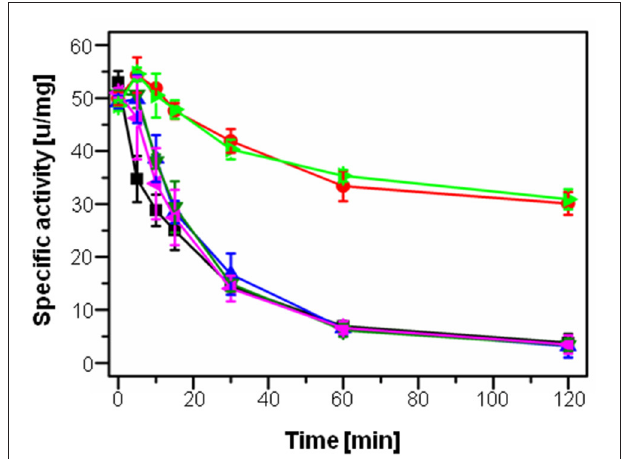
FIGURE 1 | Specific activity of HodC upon incubation with culture supernatants of P. aeruginosa strains. 100 µ l/ml sterile LB medium (light green), or 100 µ l/ml culture supernatant of P. aeruginosa PA14 (blue), the lasA ::Tn mutant (black), the aprA ::Tn mutant (dark green), the prpL ::Tn mutant (pink), and the lasB ::Tn mutant (red) in sodium phosphate buffer (pH 8.0) were incubated with 0.75 µ g/ml HodC at 37 ◦ C, and enzyme activity was measured at different time points. Error bars indicate standard deviations from three independent